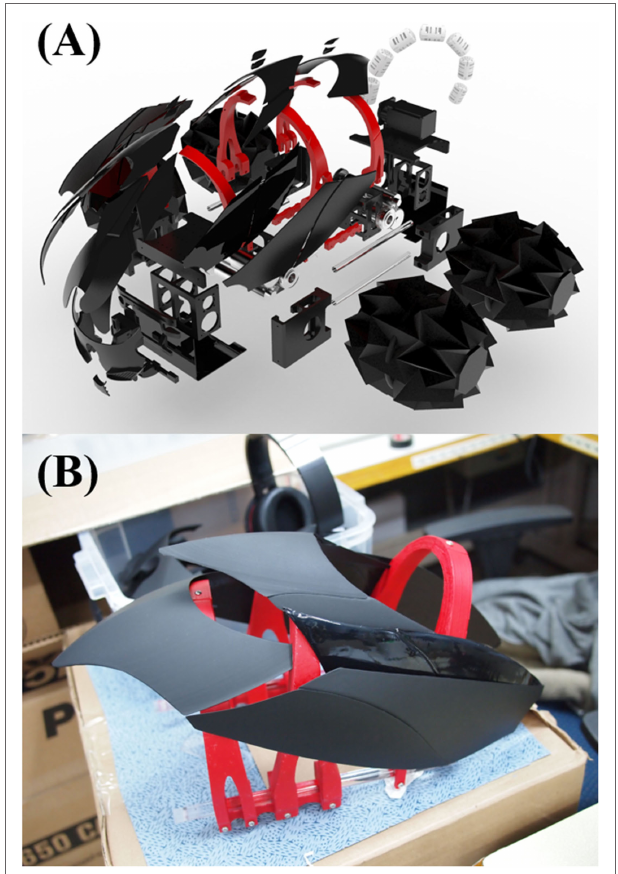
FigUre 9 | 3D model of snUMaX . (a) Computer-aided 3D-rendered model. (B) Ribs and shells of